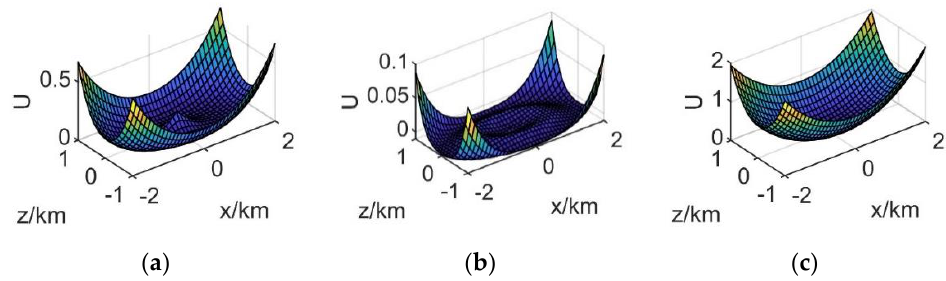
Figure 9. Bifurcating potential field ( k f = 1 kg/kms 2 , a = 1, b = 0.5). ( a ) Ellipse potential field